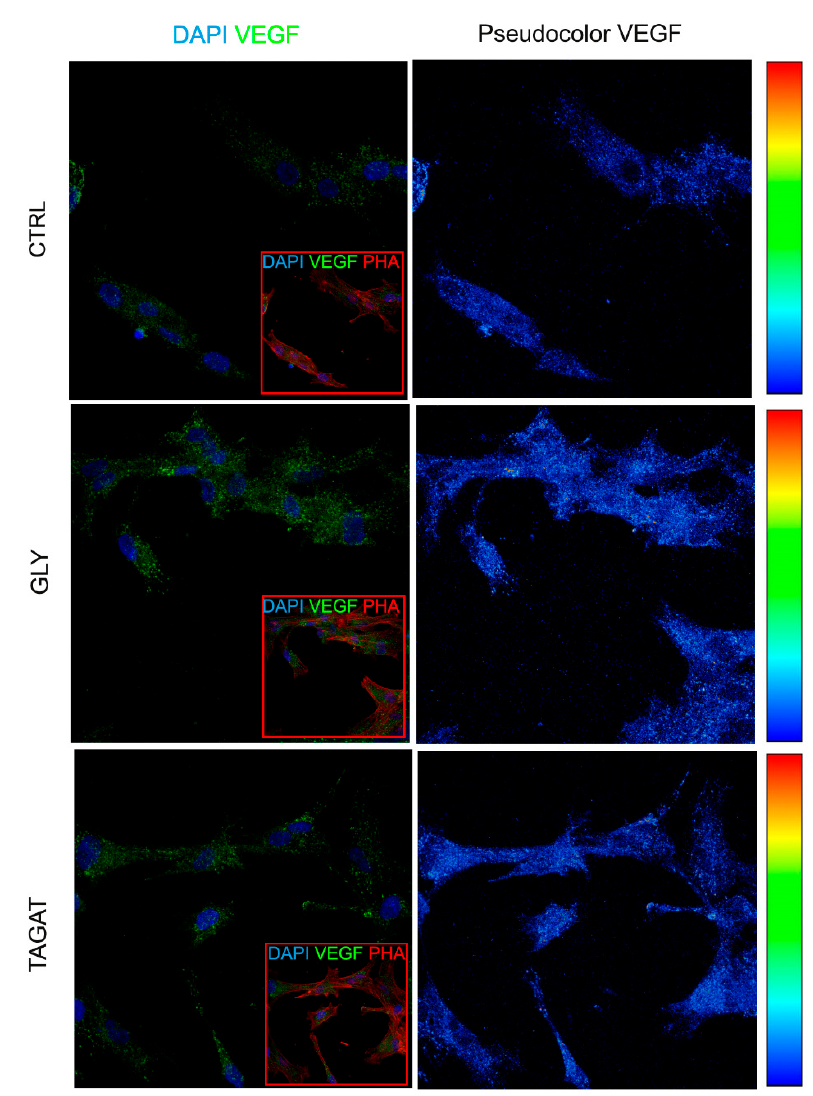
Figure 5. Angiogenic phenotype of hDPSCs after different air-polishing treatments. Analysis of VEGF expression by immunofluorescence analysis on hDPSCs seeded on titanium disks previously cleansed with GLY and TAGAT. Control group (CTRL) consisting of hDPSCs seeded on untreated titanium surfaces. Red squares show the morphology of hDPSCs after staining with phalloidin (PHA). Nuclei were counterstained with DAPI. Pseudocolor analysis of VEGF is shown on the right side. Scale bar = 10 µm.